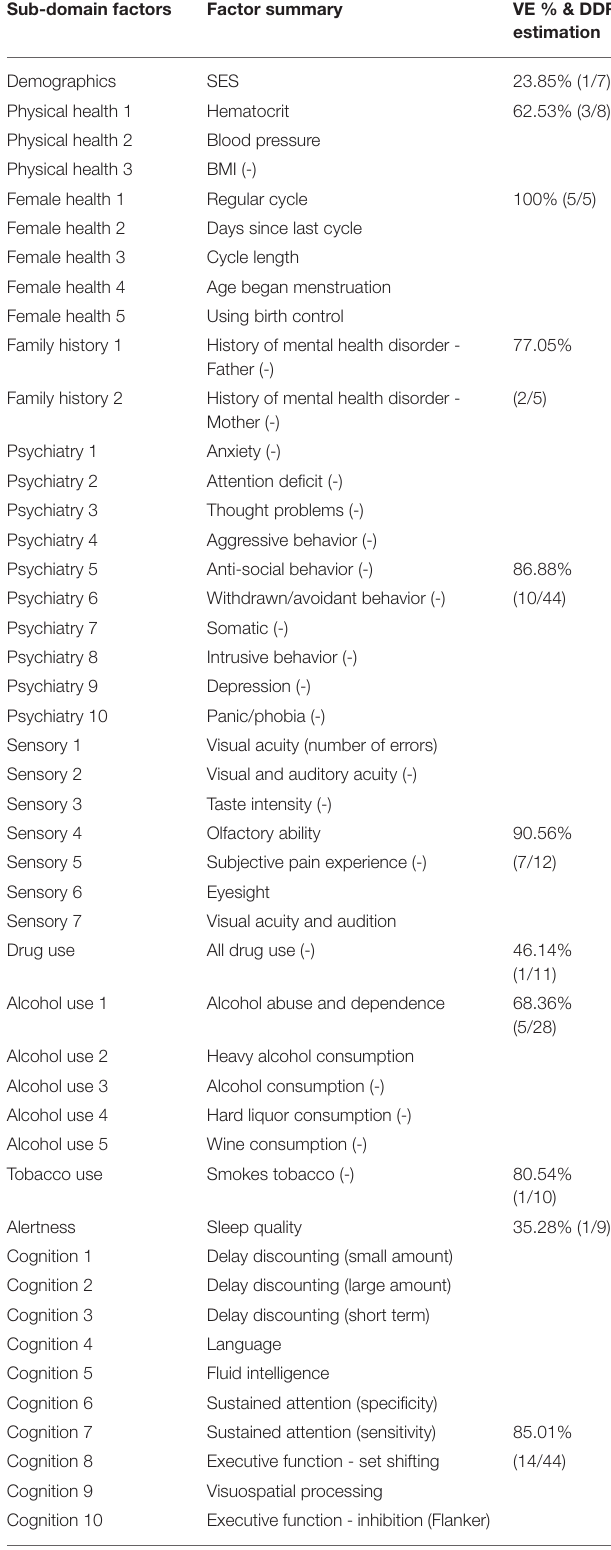
TABLE 2 | Summary of Subject Measure (SM) sub-domain